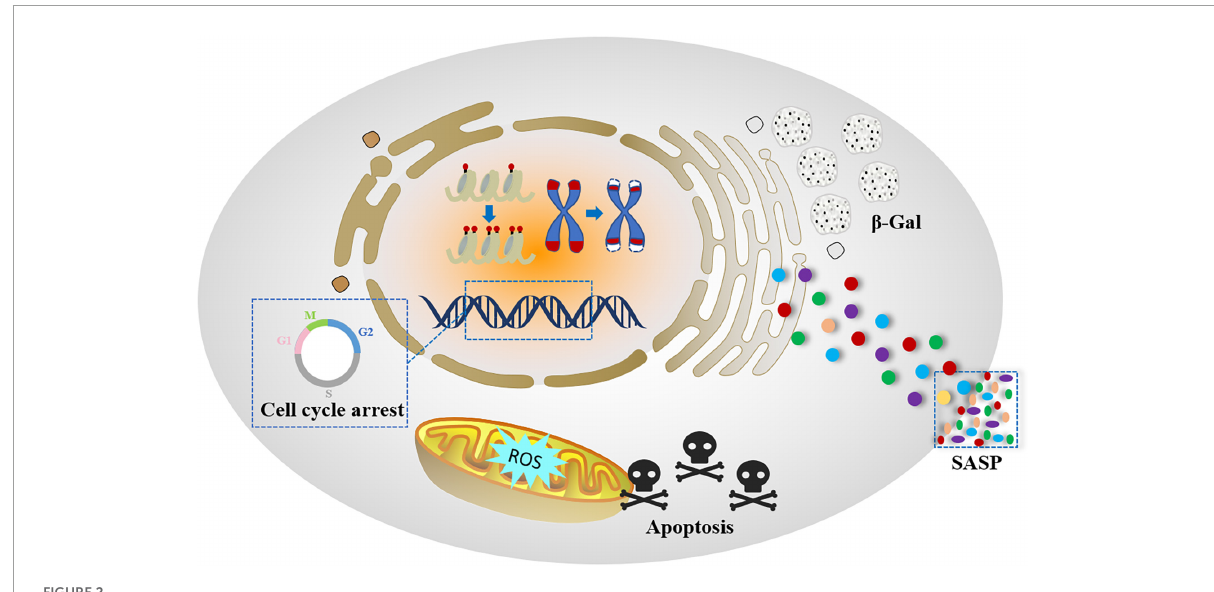
FIGURE2 Pattern diagram of senescent cell